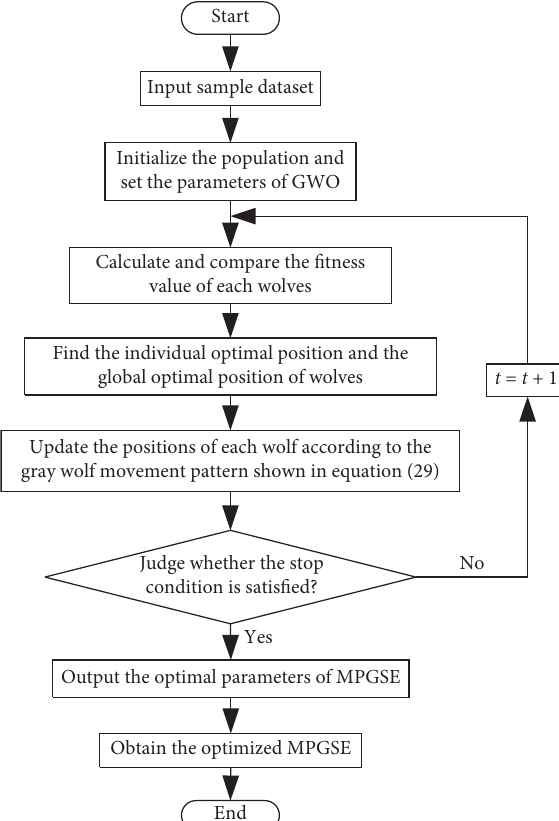
Figure 13: Flowchart of parameter optimization of